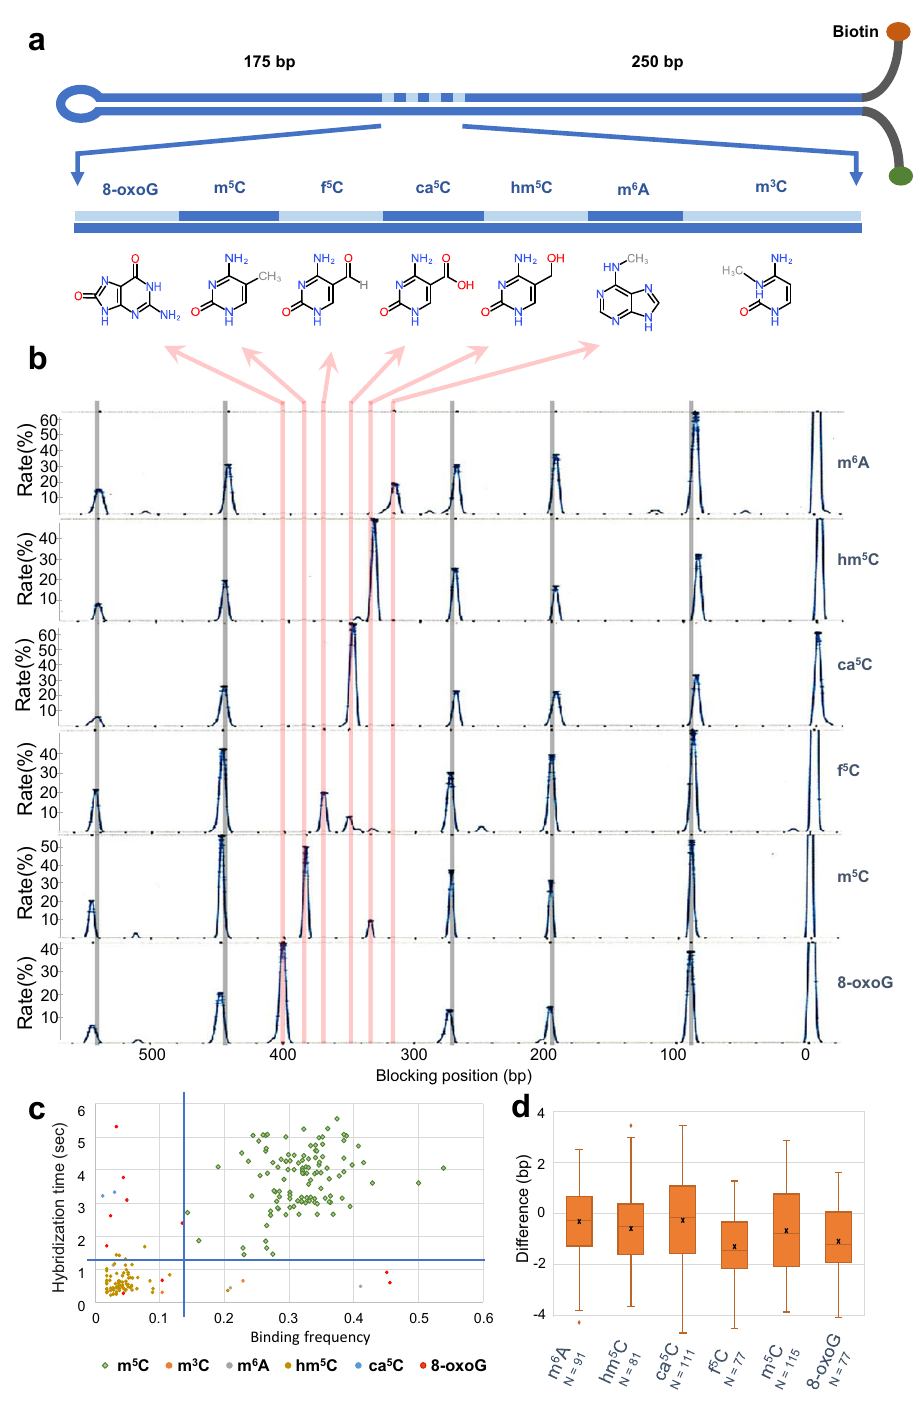
Fig. 2 Detection and mapping of DNA base modi fi cations. a Schematic representation of the hairpin constructed with seven different base modi fi cations. Each oligonucleotide contained a DNA base modi fi cation and the linker was constructed by annealing on a splint template. A detailed protocol how this hairpin is produced is available as Supplementary Fig. 1. b Detection of six out of the seven modi fi cations present on the same molecule by sequentially injecting the antibody corresponding to each base modi fi cation. The six different experiments were aligned using the reference oligonucleotide bindings. c By plotting the hybridization time versus binding frequency, it is possible to cluster true positives (in this case, the m 5 C modi fi cation with the anti-m 5 C antibody) from the false positives (principally the hm 5 C modi fi cation). Each point represents the cumulative binding data for the m 5 C antibody as determined for each modi fi ed base on each individual hairpin (note that for many hairpins, there were no false binding events, so fewer points are plotted). By thresholding the time and frequency, we can eliminate the false positives. d Antibody binding positions were mapped to the hairpin molecule within 1 bp resolution for the majority of the molecules. Whisker boxes represent 50% of the points with the average as a line within the box and the median as a